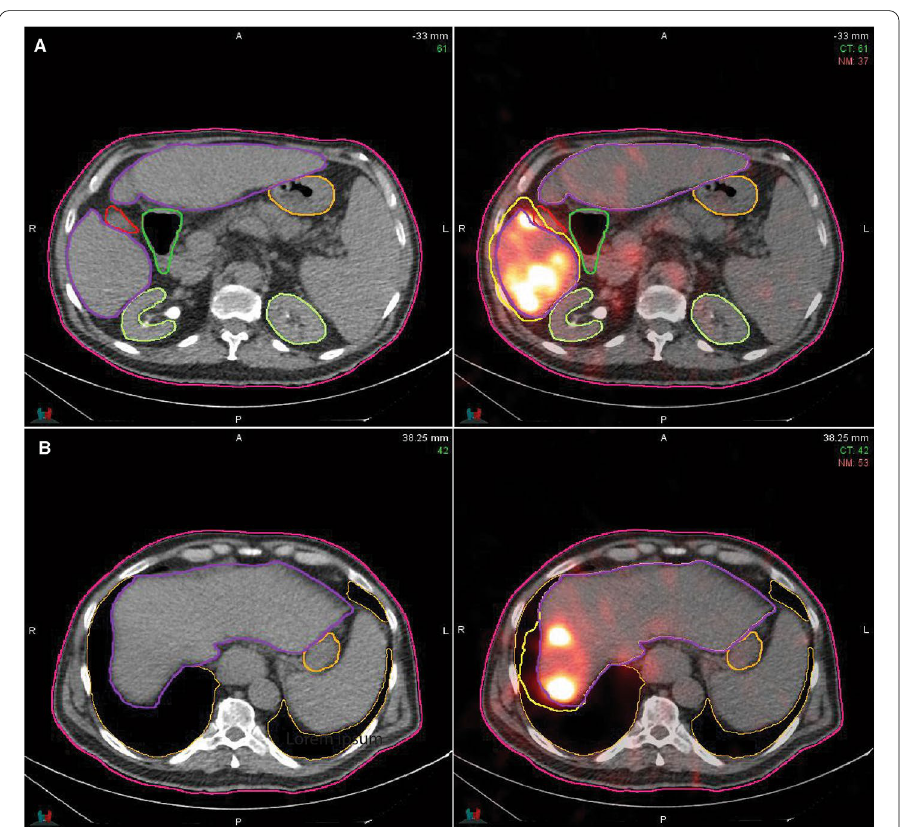
Fig. 1 Contour of two axial slices for one patient are visualized where the left represents the CT and the right represents a SPECT/CT-fused image. The purple contour represents the original liver contours whereas the yellow represents the correction contour that includes valid, but misplaced activities either due to patient motion or partial volume